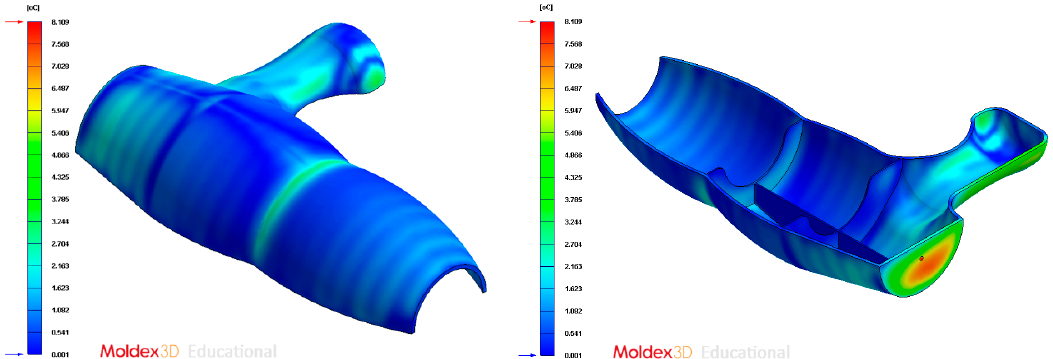
Figure 25. Gradient temperature (°C) on the mold surface after the cooling phase, Case B. Front view ( left ) and bottom view ( right ).